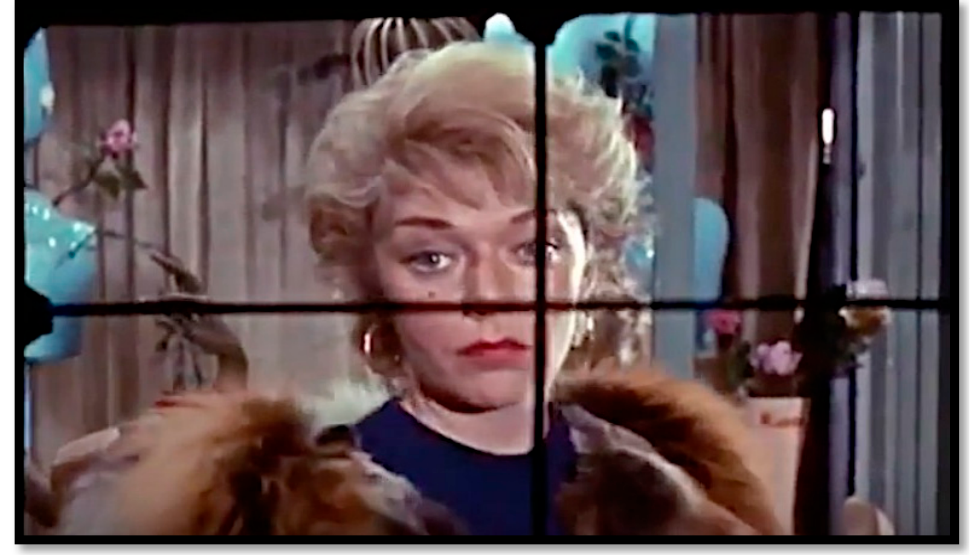
Figure 5. Image from Peeping Tom (1960) [25].